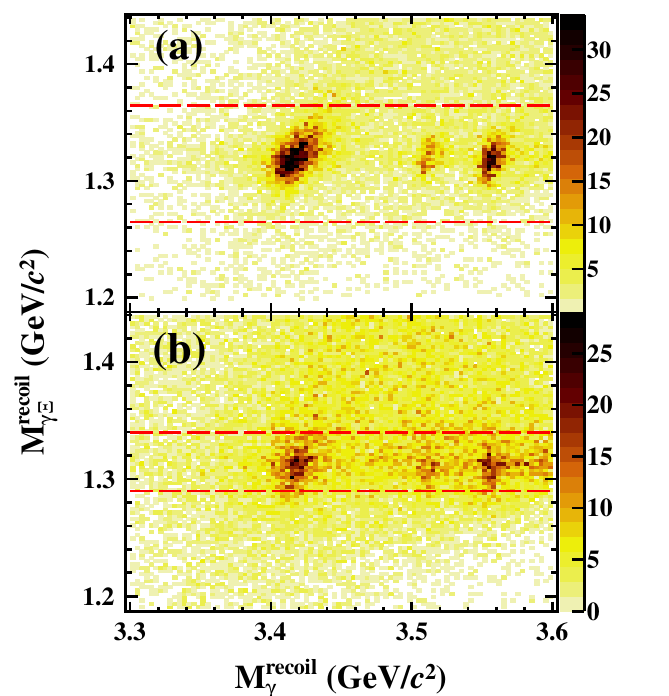
Figure 1 . 2D distributions of M recoil χ cJ → Ξ 0 ¯Ξ 0 processes. The dashed lines indicate the signal